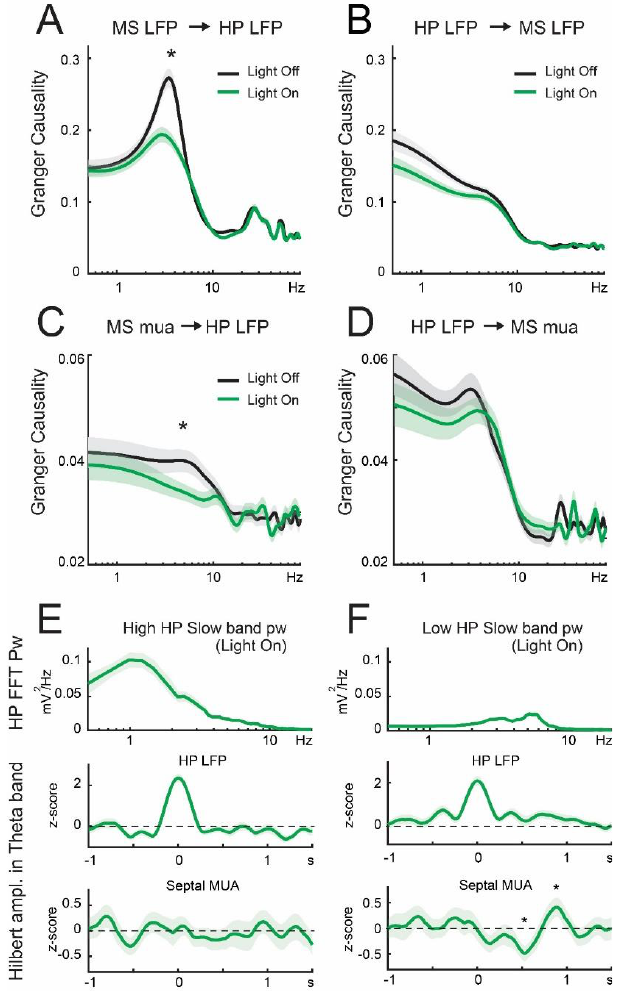
Figure 4. Granger causality between medial septum and dorsal hippocampus during optical inactivation of septal somatostatin cells. ( A ) Averaged Granger causality from the septal LFP to hippocampal LFP (MS LFP -> HP LFP). Septal somatostatin cell inhibition statistically decreases the peak fre- quency. Asterisk in band 3–6 Hz: W = 52,226, p = 2 × 10 − 6 , Wilcoxon signed-rank test, n = 405 trials. ( B ) Reverse Granger causality (HP LF -> MS LFP) is unaffected by light stimulation. ( C ) MS -> HP connectivity in theta band was weakened by inhibition of septal somatostatin neurons. Asterisk in band 3–7 Hz: paired t -test, p = 0.0143, n = 405 trials. ( D ) HP -> MS connectivity is apparently unaf- fected by optogenetic stimulation. ( E ) Average values for the 5th lower percentile in Granger causality HP LFP -> MS MUA and 5th upper percentile in hippocampal slow wave power ( n = 19 trials) of trials during light stimulation. Top panel: average normalized power spectral density of hippocampal LFP. Middle panel: z-scored theta-filtered amplitude for hippocampal LFP averaged with peak value set at t = 0. Bottom panel: average z-scored theta-filtered amplitude for septal LFP and referred to peak value of hippocampal theta. ( F ) Average values for the 5th upper percentile in Granger causality HP LFP -> MS MUA and 5th lower percentile in hippocampal slow wave power ( n = 19 trials) of trials during light stimulation. Top panel: average normalized power spectral density of hippocampal LFP. Middle panel: z-scored theta-filtered amplitude for hippocampal LFP averaged with peak value set at t = 0. Bottom panel: average z-scored theta-filtered amplitude for septal LFP and referred to peak value of hippocampal theta. Asterisk denotes significant difference against zero (Wilcoxon signed- rank test, FDR correction, p <